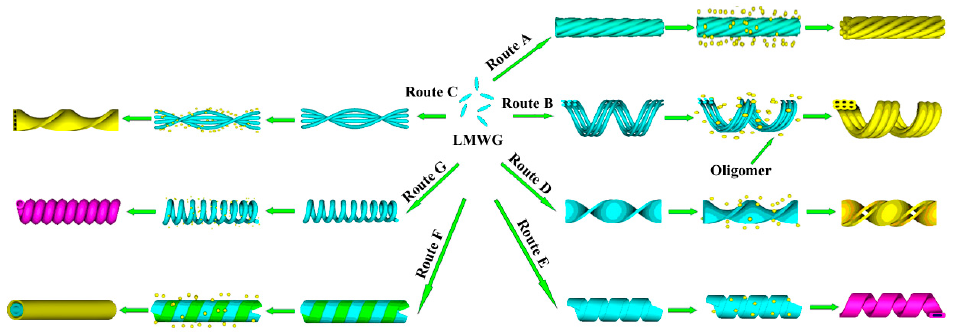
Figure 6. Schematic illustration of formation of single-handed helical polybissilsesquioxane